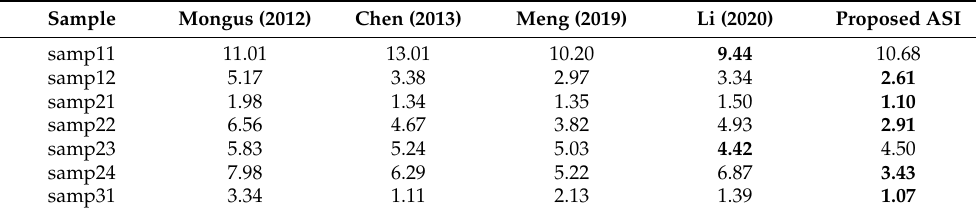
Table 5. Comparison between the T.E. values (%) of the proposed method and other interpolation- based methods. (The best results across all the methods at each sample are highlighted in